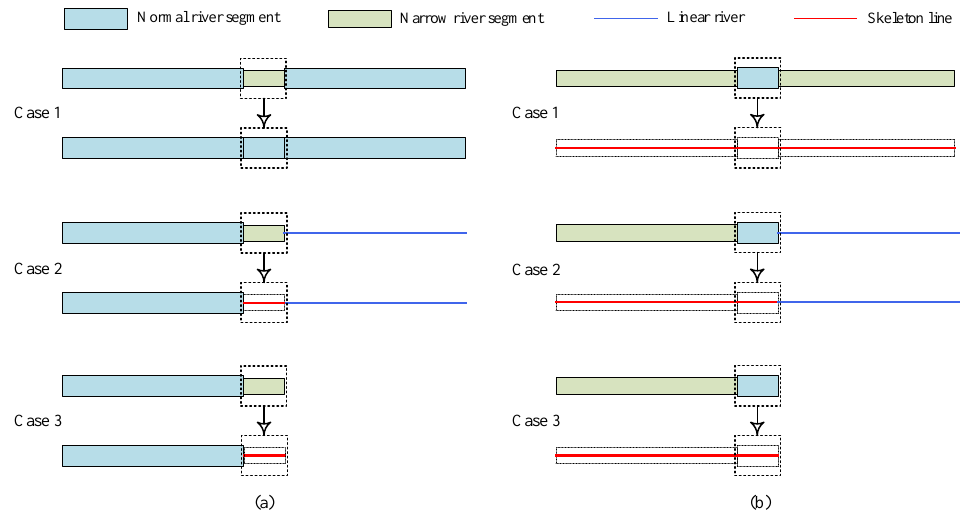
Figure 7. Handling mode of isolated short river segment. ( a ) Three cases of narrow and short river segment, and ( b ) three cases of normal short river segment.